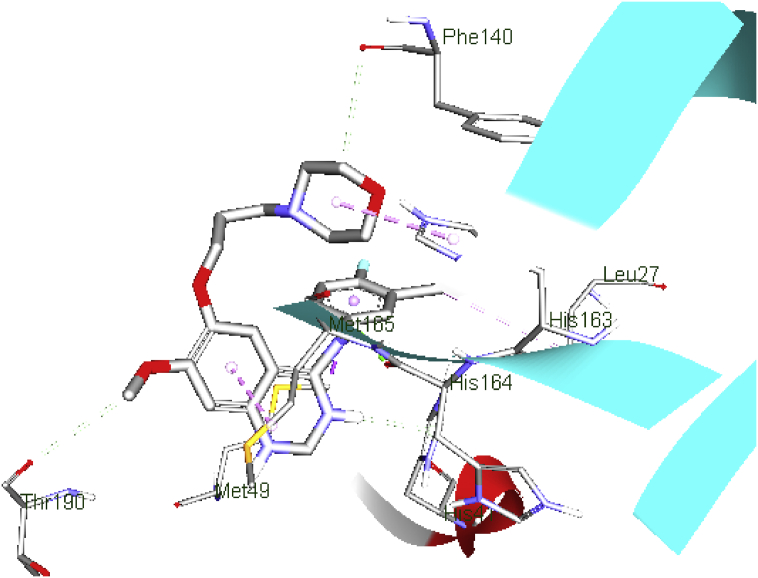
Schematic representation of C19MP (PDB: 6LU7) interactions with gefitinib.Image 1 protein Image 2 ligand Image 5 hydrophobic interaction Image 6 carbon-hydrogen bond.